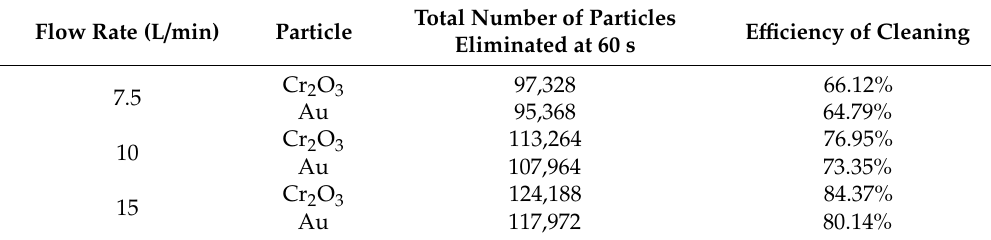
Figure 12. Total accumulated particles flowing out of the UCT’s outlet for the flow rate of 7.5, 10, and 15 L/min. Table 3. Simulation results of total accumulated particles.